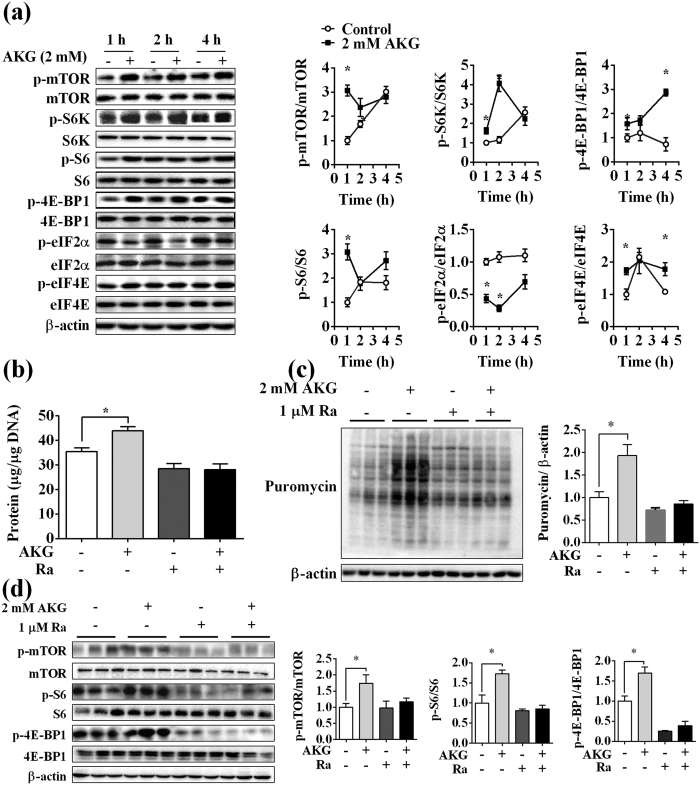
mTOR signaling pathway mediated AKG-induced protein synthesis in C2C12 myotubes.(a) C2C12 myotubes were treated with 2 mM AKG for 1, 2, and 4 h. The expression levels of phosphorylation of mTOR, S6K, S6, 4E-BP1, eIF2a, and eIF4E were detected by Western blot. (b) C2C12 cells were cultured for 6 d in a differentiation medium. mTOR inhibitor rapamycin (1 μM) was used alone or co-treated with AKG (2 mM) for 48 h. Total protein levels. (c) The expression of puromycin determined by Western blot after C2C12 cells were co-treated with AKG and rapamycin. (d) The expression levels of phosphorylation of mTOR, S6, and 4E-BP1 detected by Western blot after C2C12 cells were co-treated with AKG and rapamycin. Data are presented as mean ± SEM. *means P < 0.05 compared with the control. β-actin served as a housekeeping gene control.